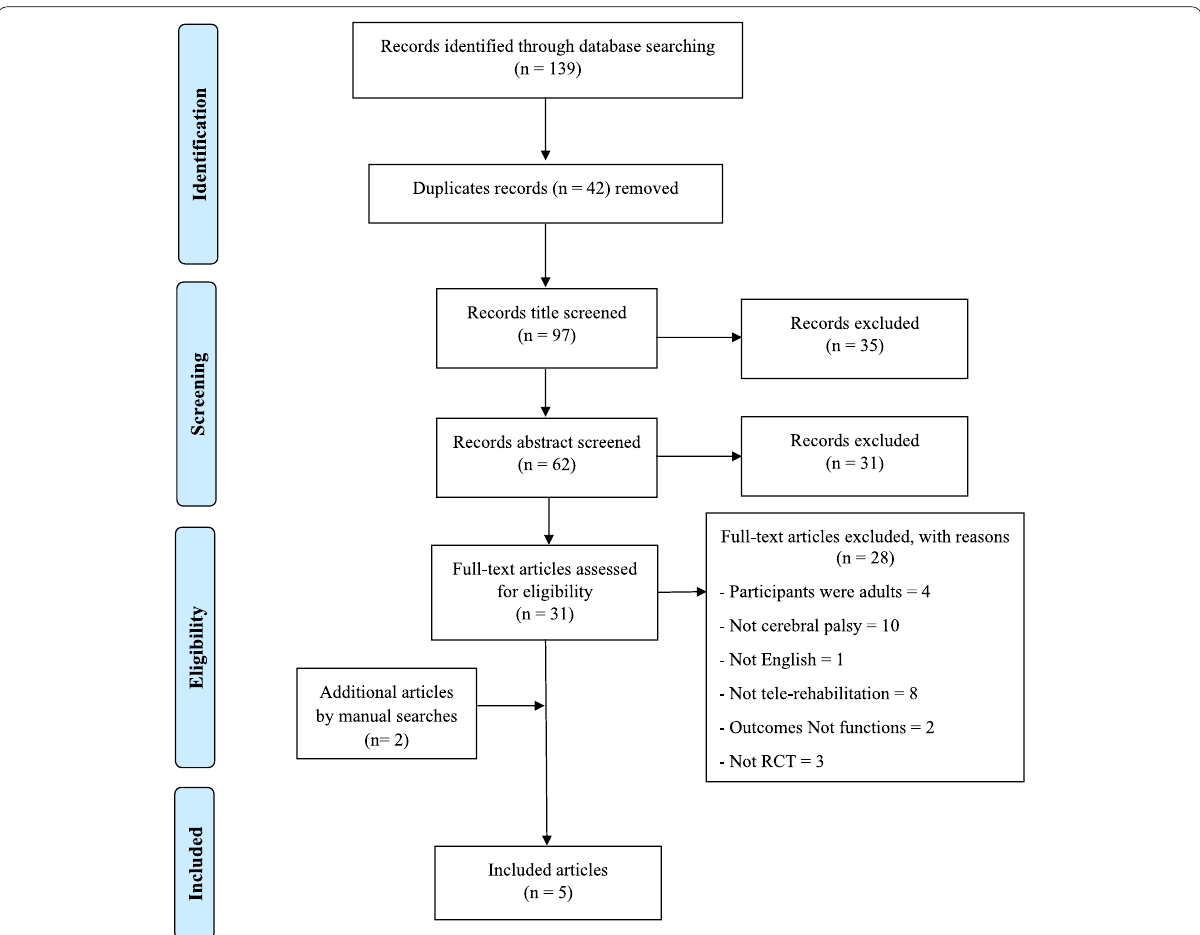
Fig. 1 Flow diagram depicting search strategy and article selection